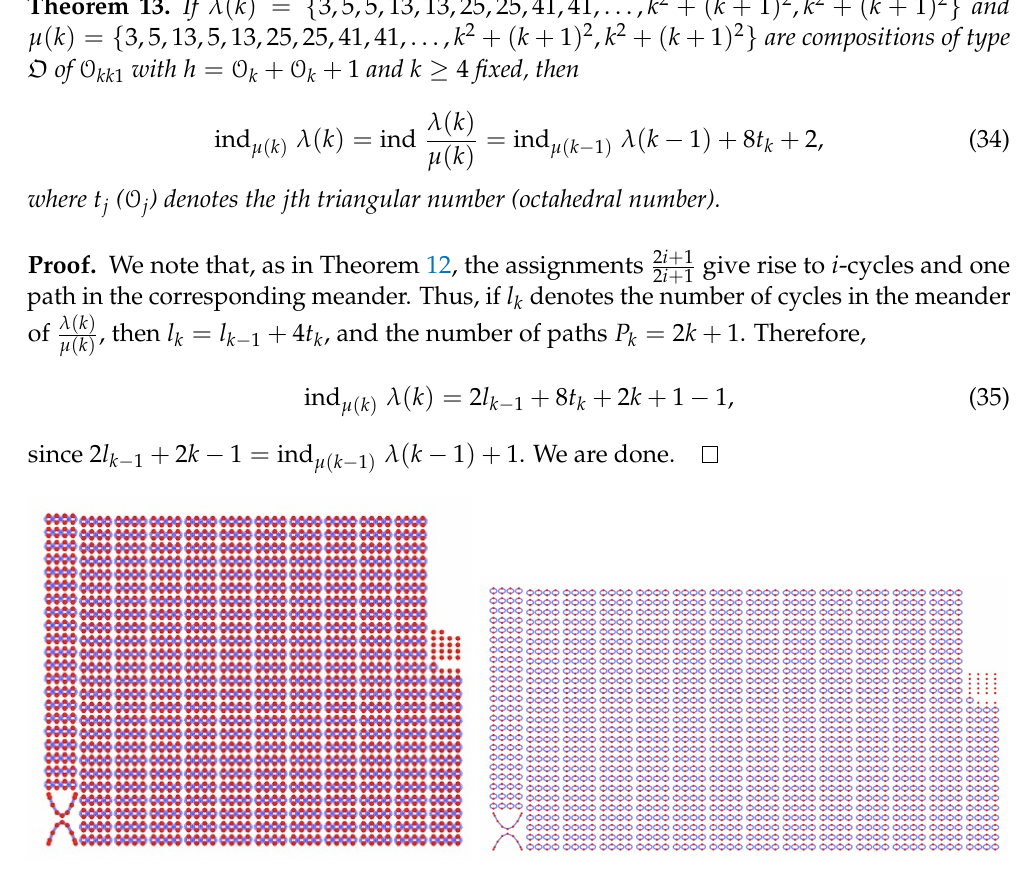
Figure 7. Cycles and paths in meander graphs induced by compositions of 2313 and 2939 of type O